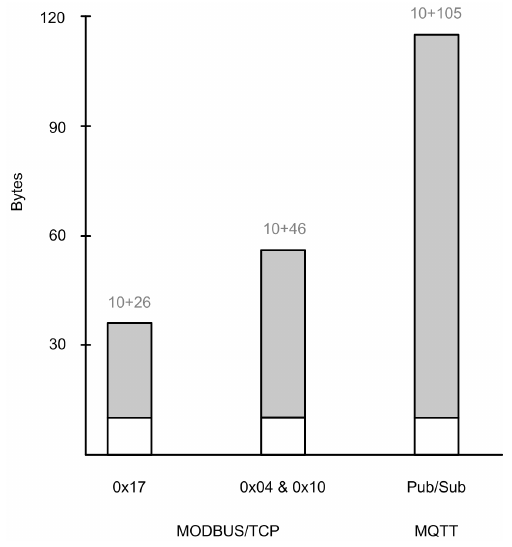
Figure 8. MQTT and MODBUS overheads for a payload of 10 bytes.